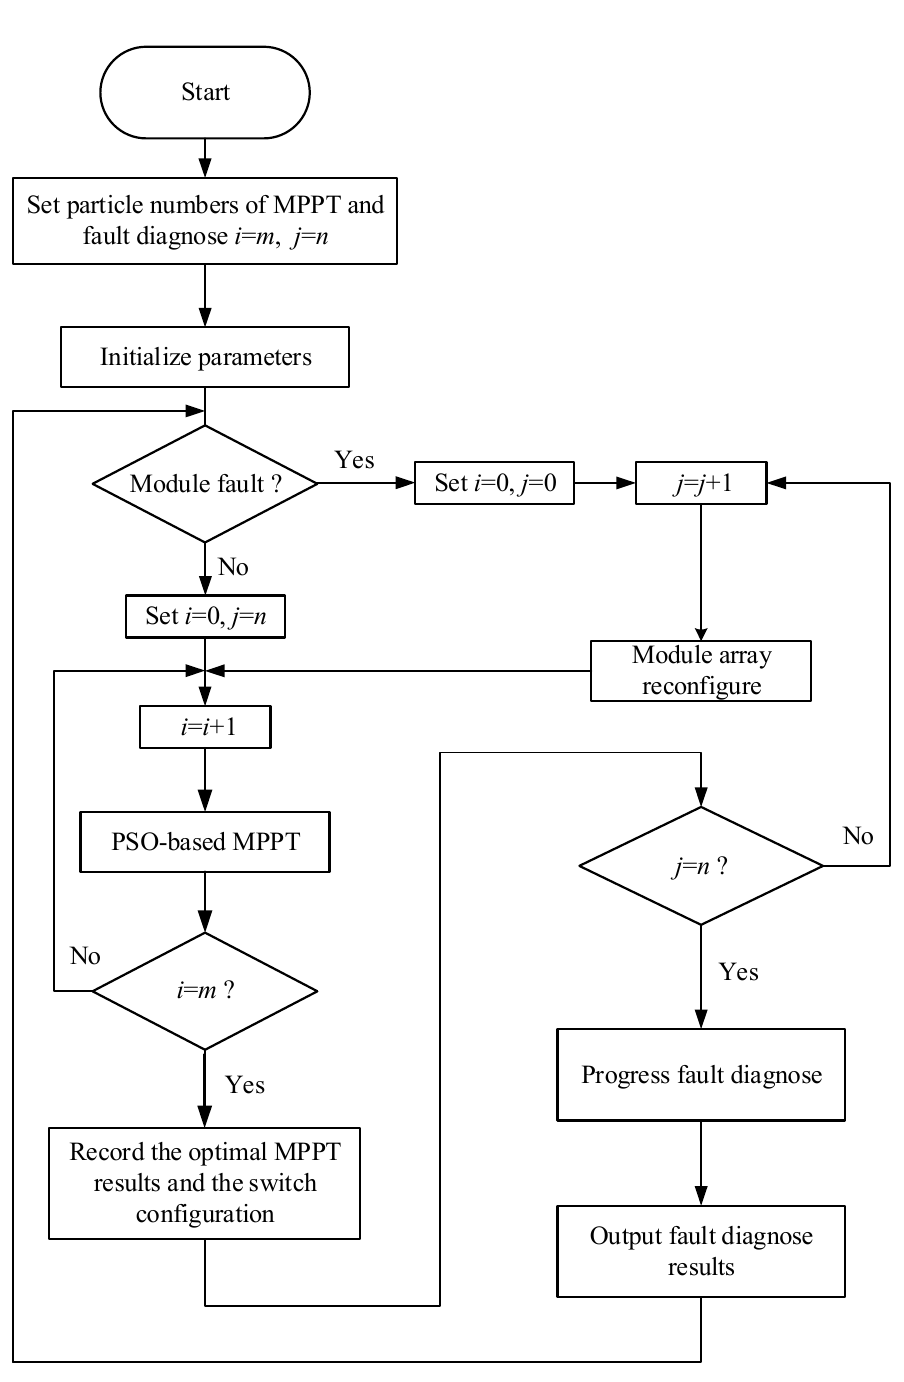
Figure 3. The step sequence of configuration optimization using particle swarm optimization (PSO) for a PV module array.